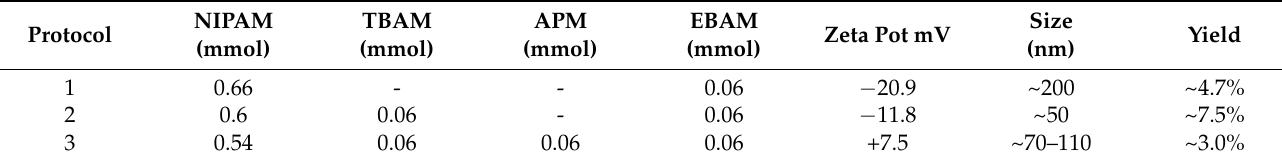
Table 1. Polymer compositions, zeta potentials, sizes, and high-affinity particle yields (with respect to overall amount of monomer) of MIP